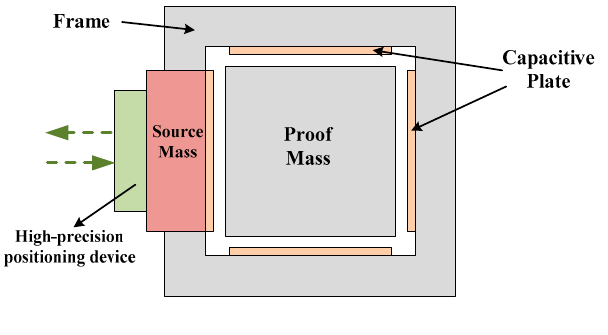
Figure 5. Schematic of TISS project.